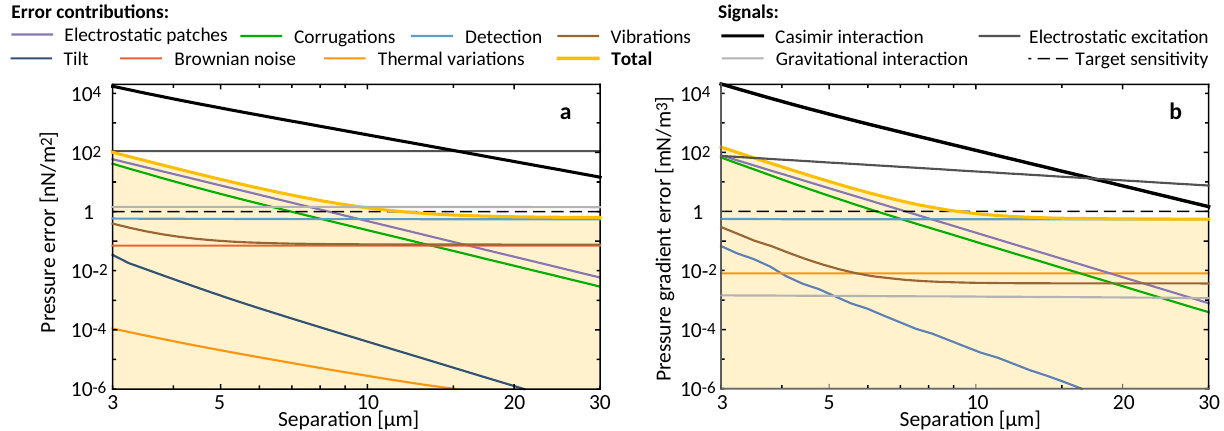
Figure 8. Error budget for the next-generation design of C ANNEX for measurements of the pressure ( a ) and pressure gradient ( b